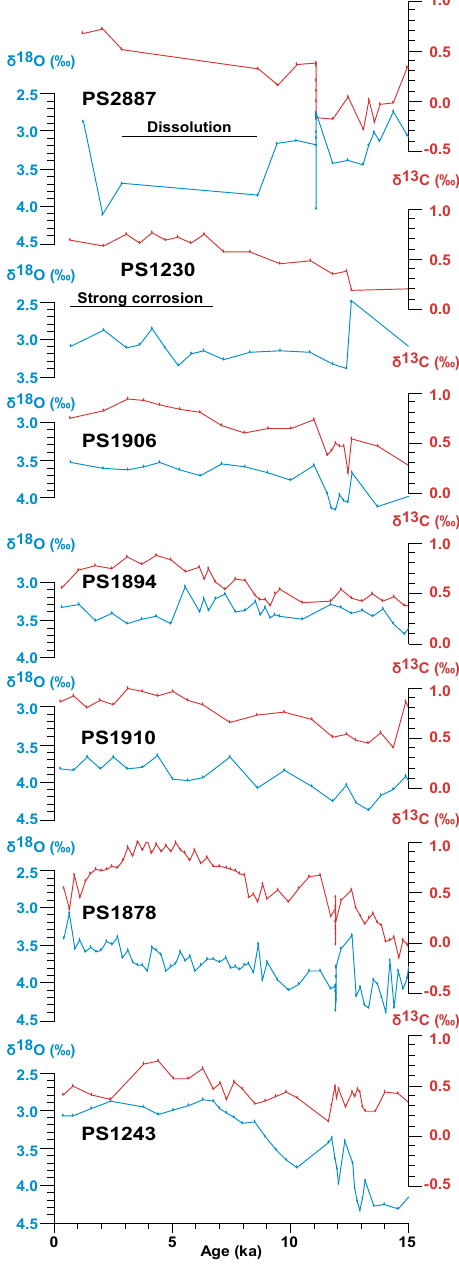
Fig. 5. Planktic oxygen and carbon stable isotope records of cores from the Nordic Seas plotted vs. age (since